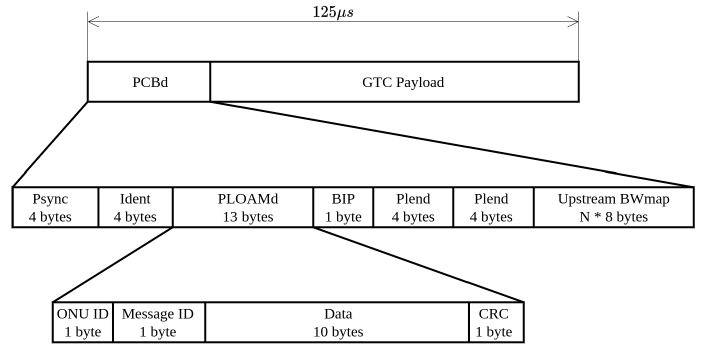
Figure 1. GPON downstream frame